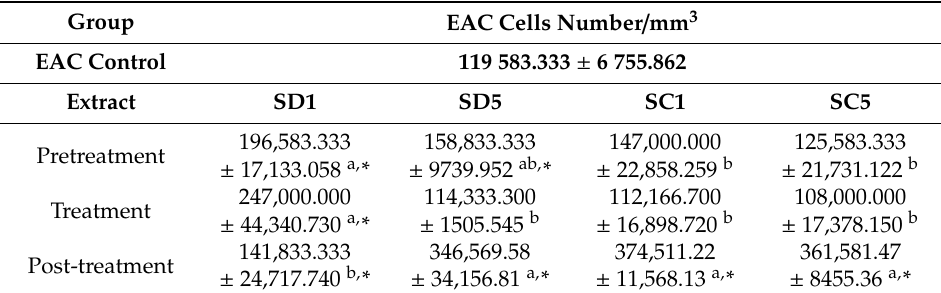
Table A3. Impact of S. montana extracts on the number of EAC